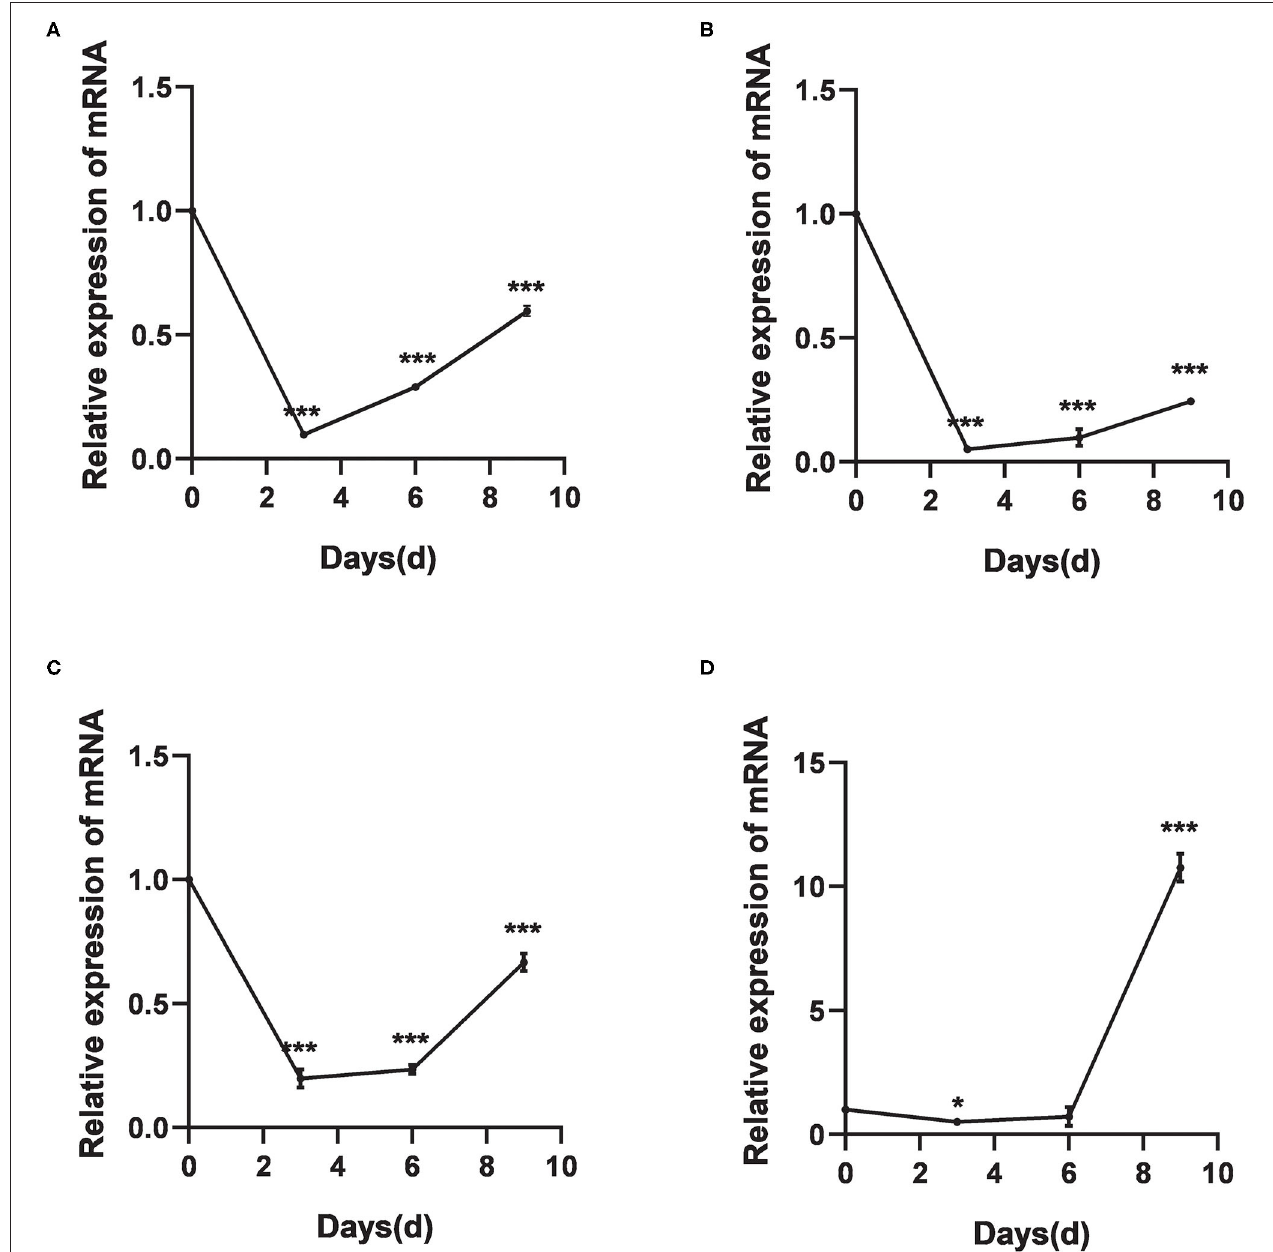
FIGURE 4 | The relative expression of DNA methyltransferase mRNAs after cold treatments vis-à-vis the untreated group. (A–D) Relative expression of DsDnmt (A) , DsDnmt1 (B) , HlDnmt1 (C) , HlDnmt (D) measured using qRT-PCR. The results are expressed as the means ( n = 3) ± SEM. The asterisks above bars indicate significant difference based on one-way ANOVA followed by Turkey’s test, * P < 0.05, *** P < 0.01.